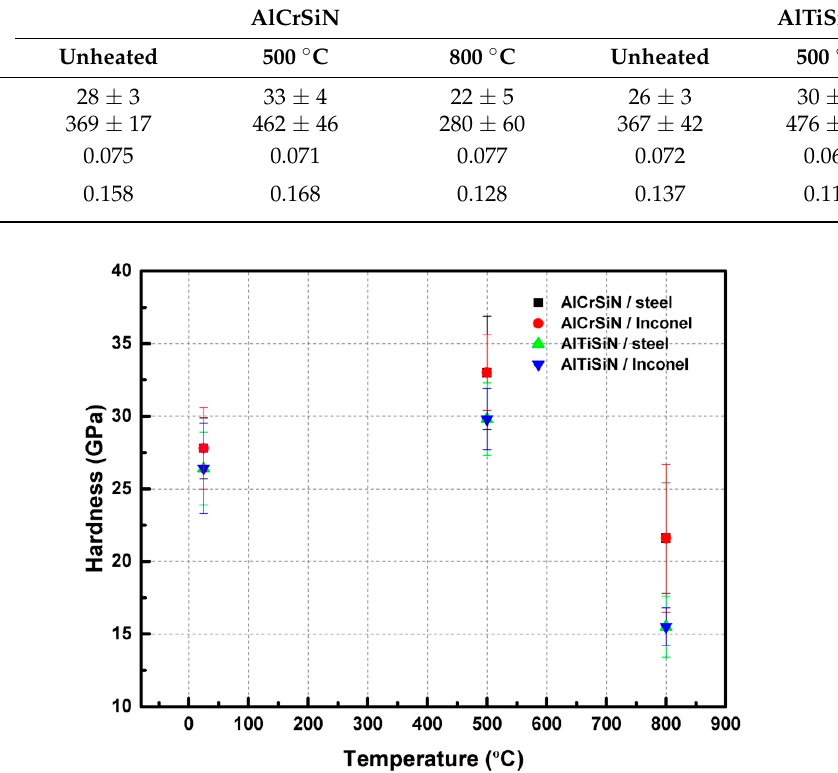
Figure 2. The relationship of the hardness of coatings with different thermal treatment.